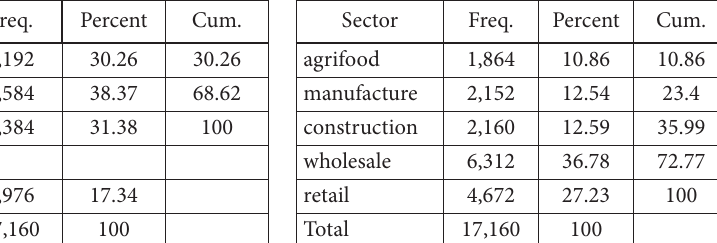
Table 1. Territorial and sectoral distribution of the sample observations